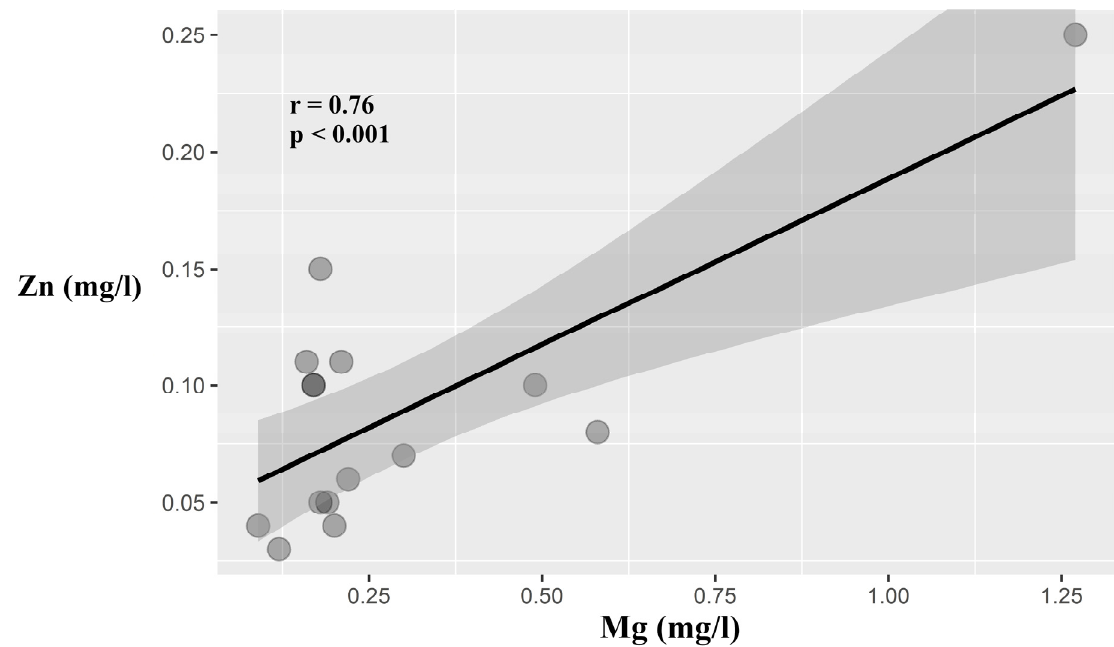
Figure 1. Scatter plot of correlation between Mg and Zn in first enamel layer.